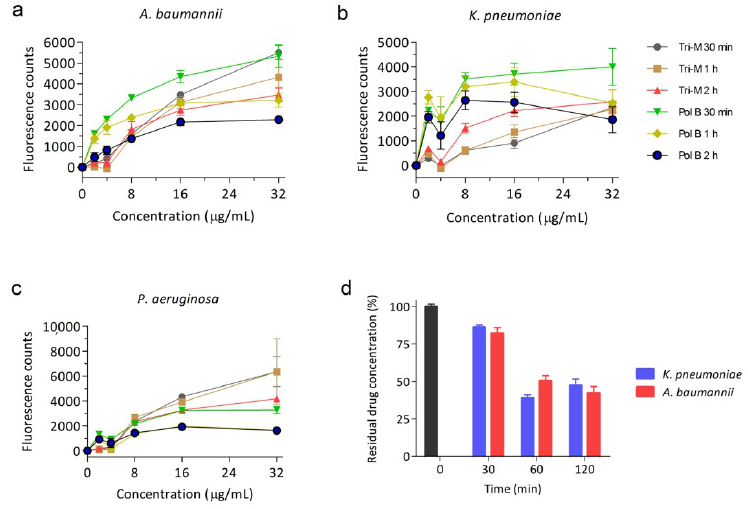
Figure 2. Tridecaptin M shows outer membrane disruption in all Gram-negative bacteria. ( a ) N -phenyl-1-naphthylamin (NPN) assay with A. baumannii . ( b ) NPN assay in K. pneumoniae . ( c ) NPN assay in P. aeruginosa . The data plotted are mean values of three biological replicates. Bars denote the standard deviation. Tri-M—tridecaptin M and Pol B—polymyxin B. ( d ) Binding kinetics of tridecaptin to bacteria determined by reversed-phase high pressure liquid chromatography (RP-HPLC) using area under the curve. The concentration of tridecaptin M was 16 µg/mL. The data plotted are the mean of three replicates and representative of two biological repeats. Bars denote standard deviation. Table 1. Synergetic activity of rifampicin and vancomycin with tridecaptin M against Gram-negative bacteria. Tri-M Concentration Strain Tri-M MIC ( µ g / mL) Antibiotic MIC ( µ g / ( µ g / mL)